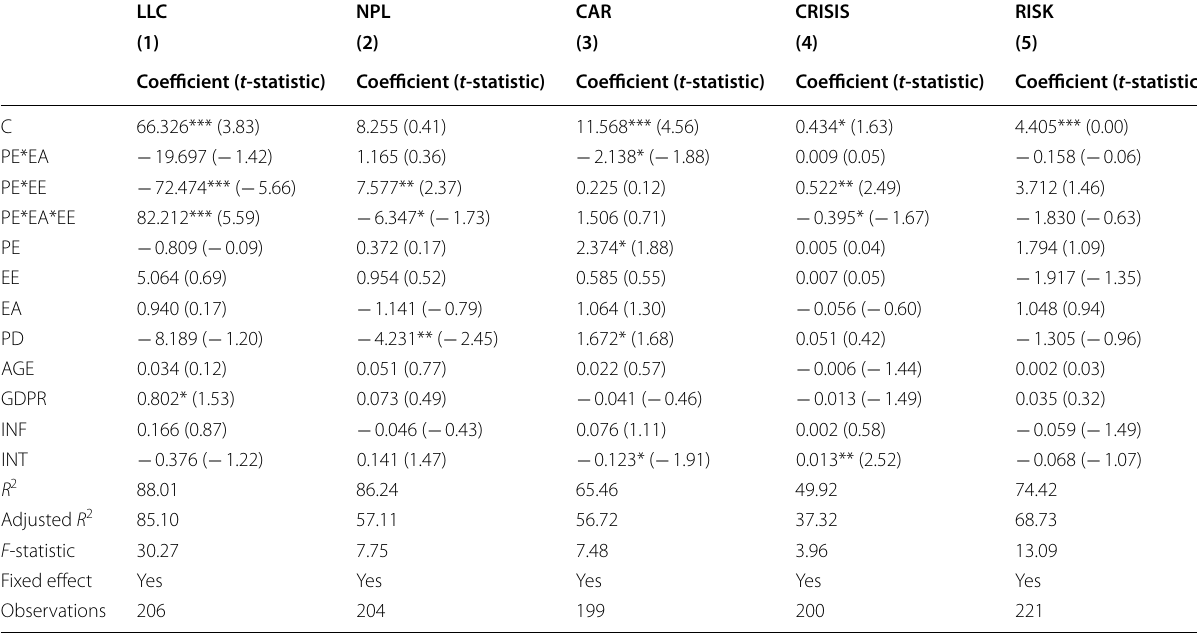
The results in this table are estimated using fixed-effect regression. Country and period fixed effect were applied ***, **, * represent significance at 1%, 5%,